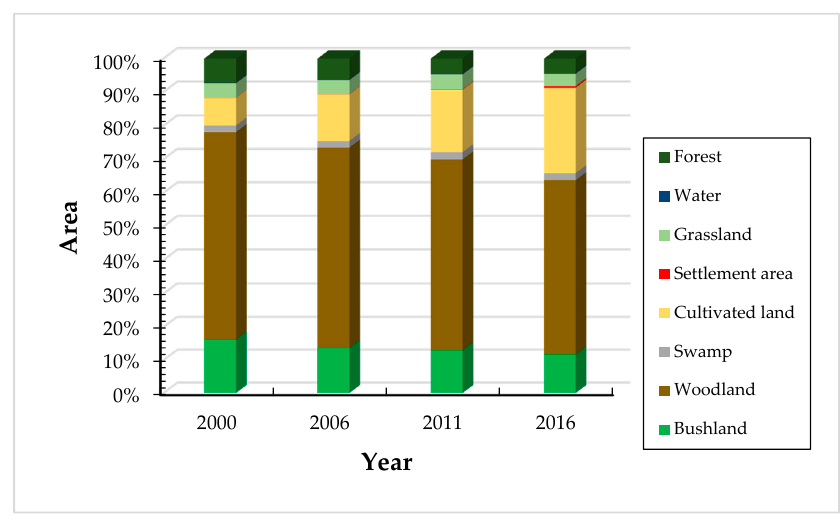
Figure 4. LULC change graph for 2000, 2006, 2011, and 2016 at Wami Sub-catchment. Table 9. Results of the LULC classification for 2000, 2006, 2011, and 2016 images showing the area changed and percentage at Wami Sub-catchment.